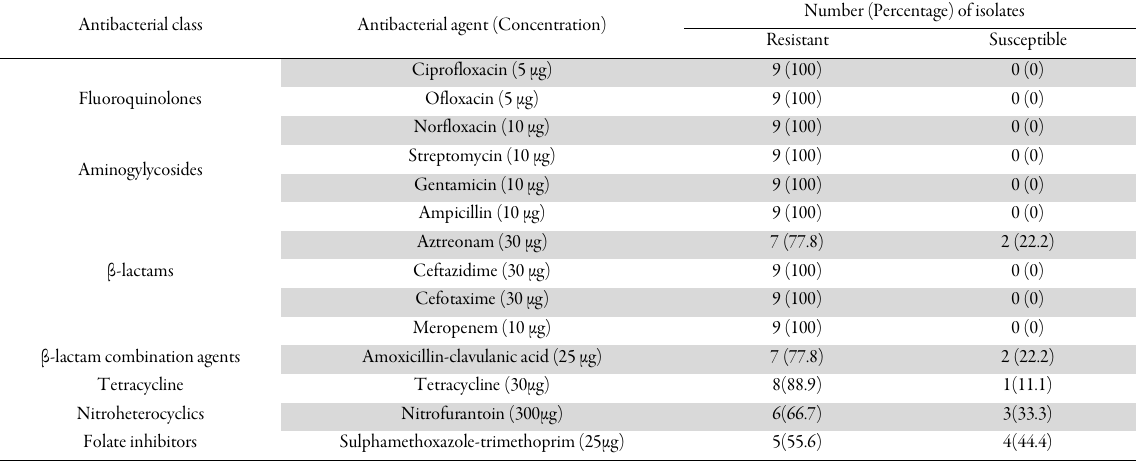
Table 1. Antibacterial susceptibility profile of 9 generic faecal Salmonella isolates from healthy adults in Ankpa Northcentral Nigeria